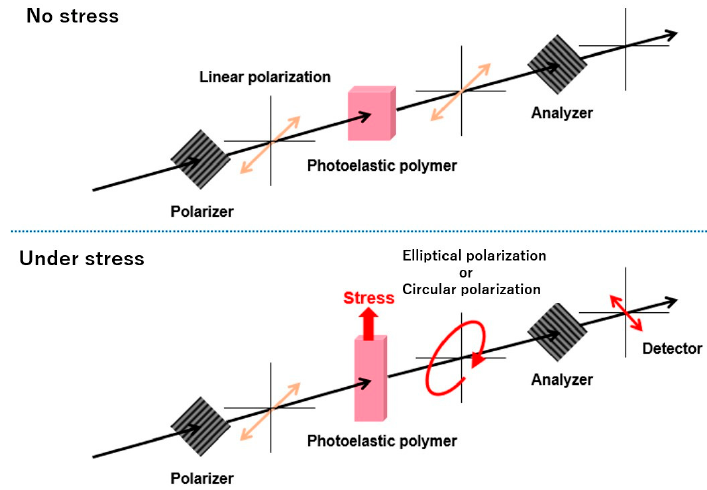
Scheme A1. Stress measurement method using photoelasticity.